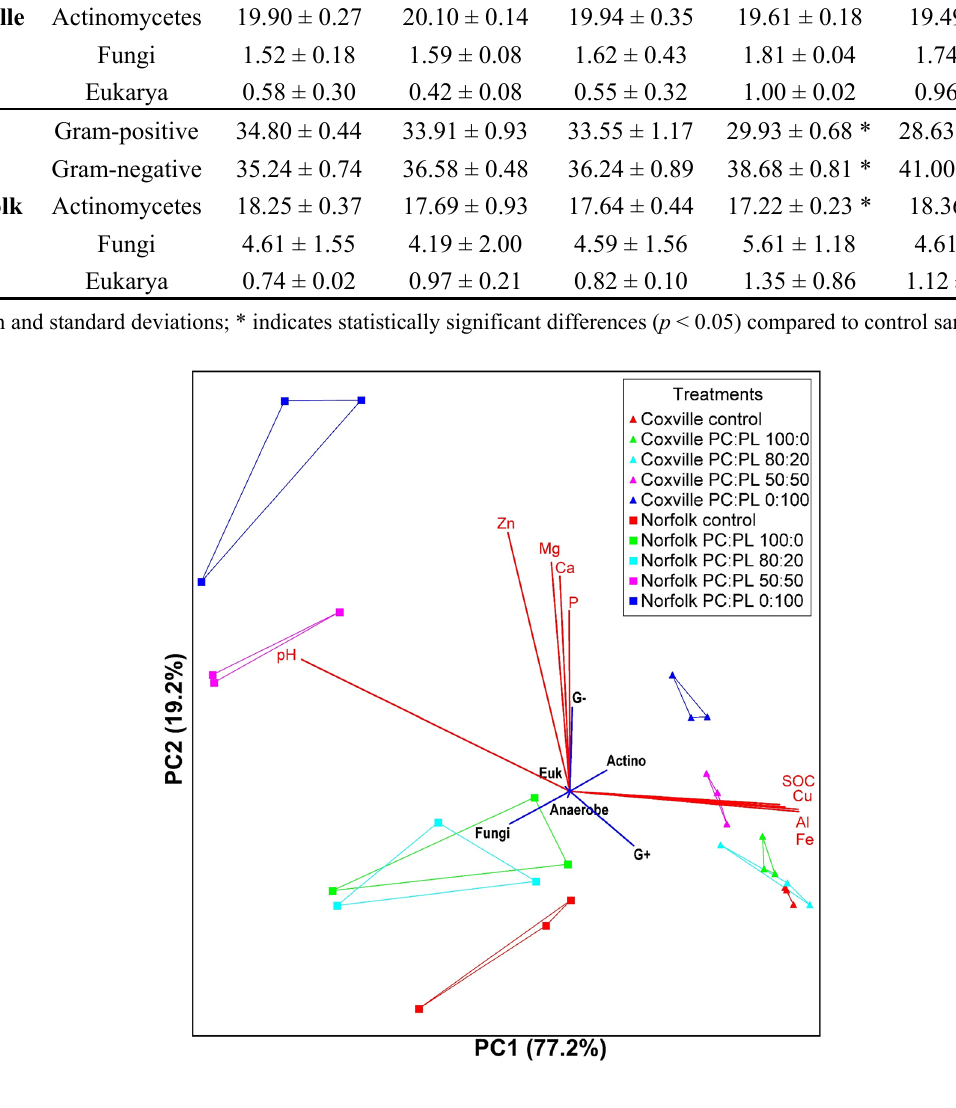
Figure 3. Principle component (PC) analysis ordination plots using PLFA groups indicating changes to the microbial community structure of non-amended Coxville ( ▲ ) and Norfolk ( ■ ) soils, or the same soils amended with PC:PL 0:100, PC:PL 80:20, PC:PL 50:50, or PC:PL 0:100 biochar mixtures added at a 2% w:w volume. Numbers in parentheses along each axis represents the percent variance explained. Joint plot vectors (red lines) were selected for display based on a combined axis r 2 cutoff of 0.60 (see Table 4). Blue lines represent microbial PLFA groups and their directional trend along the two axis